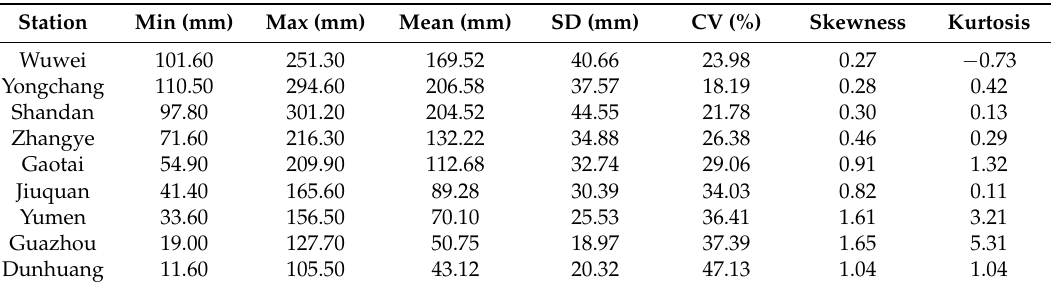
Table 4. Statistical parameters of annual precipitation at the meteorological stations during the study period.